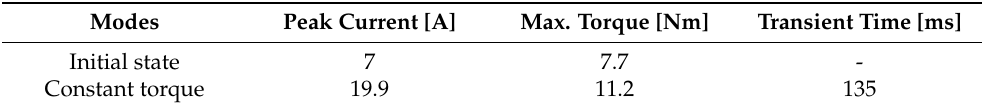
Figure 18. Transient state of constant-torque mode at 480 r/min and 5A. Table 12. Transient state of constant-torque mode. Table 12. Transient state of constant-torque mode.